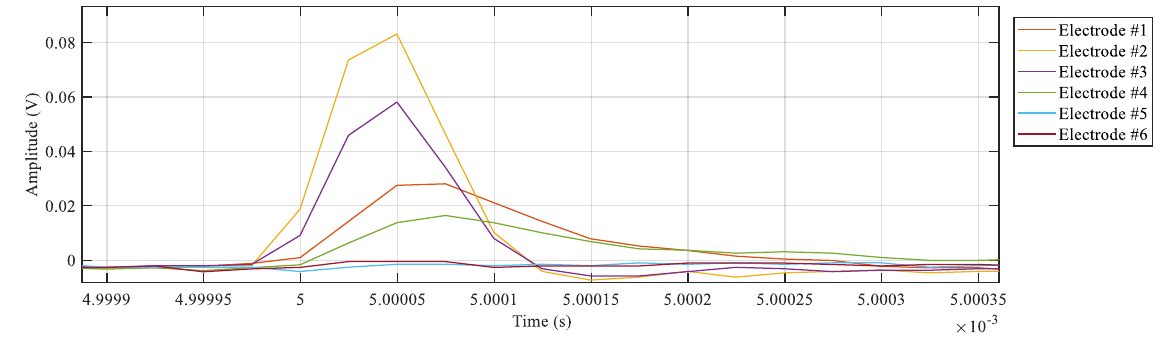
Figure 11. Measured voltage at the electrodes during a PD.